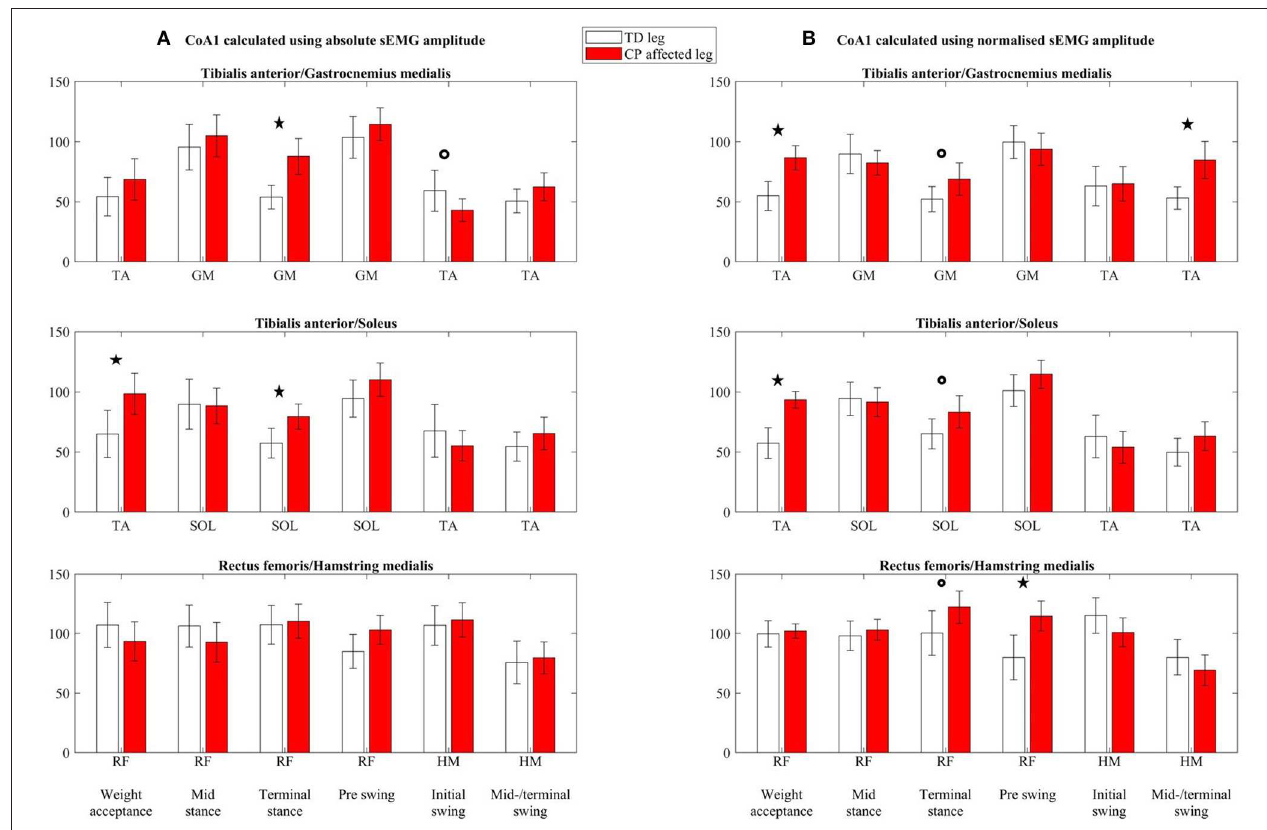
FIGURE 4 | Coactivation index 1 (CoA1) calculated using (A) absolute sEMG-RMS amplitudes (CoA1-abs) and (B) using normalized sEMG-RMS amplitudes (CoA1-norm), presented as mean with 95% confidence interval. Calculated for three coactivation muscle pairs: tibialis anterior/gastrocnemius medialis, tibialis anterior/soleus, and rectus femoris/hamstring medialis, for each of the six gait phases (named in the bottom line). The agonist in the coactivation index muscle pair is indicated for each gait phase below each subplot. TA, tibialis anterior; GM, gastrocnemius medialis; SOL, soleus; RF, rectus femoris; HM, hamstring medialis. *Significant group differences ( p < 0.05), ◦ p <